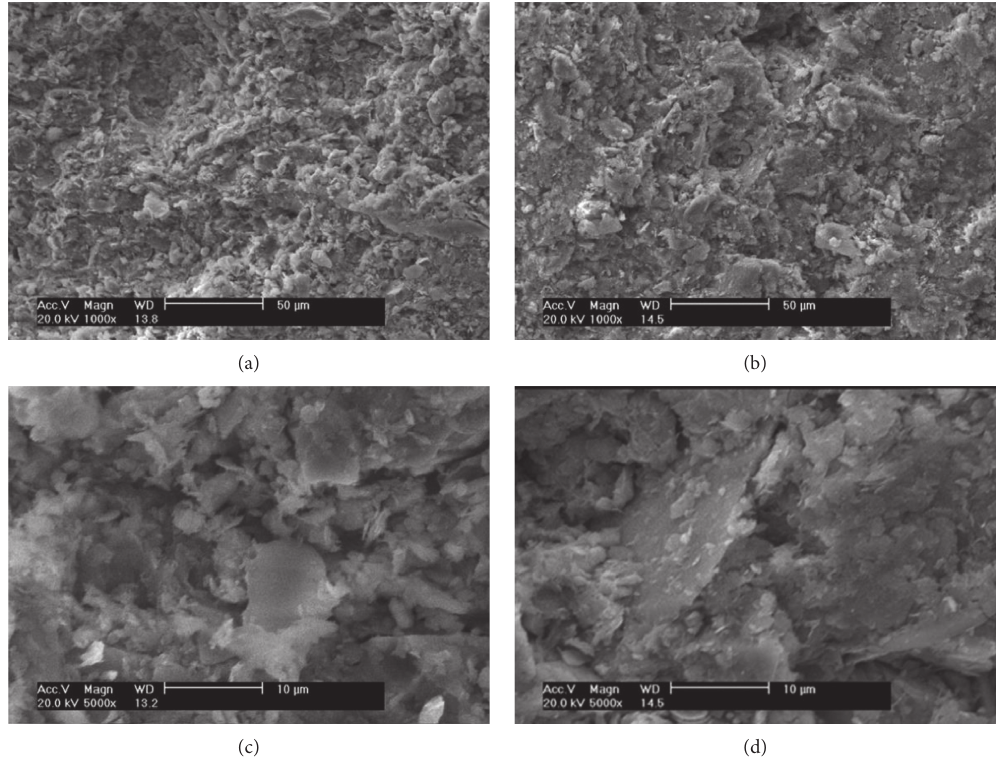
Figure 14: The SEM images for (a) undisturbed soil with a magnificationof 1000 times; (b)soil samplesafter theoedometer test with a magnification of 1000 times; (c) undisturbed soil with a magnification of 5000 times; and (d) soil samples after oedometer tests with a magnification of 5000 times.